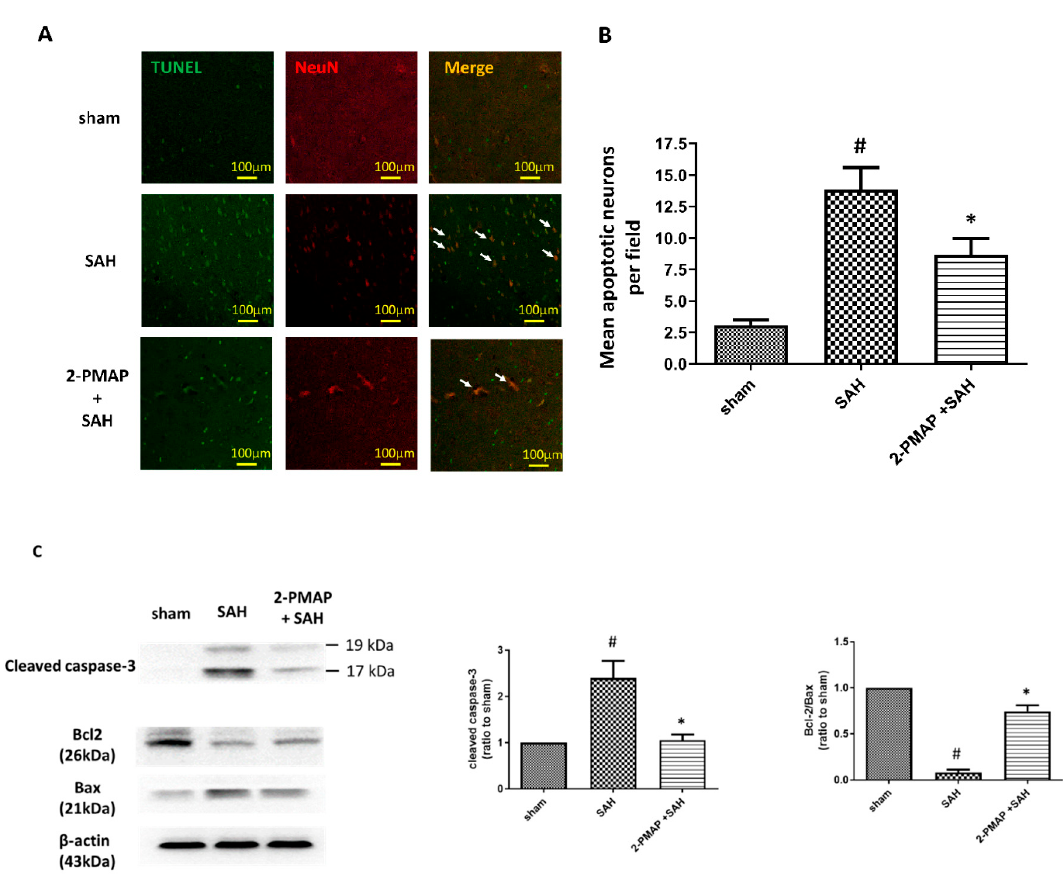
Figure 2. 2-PMAP decreased apoptotic neurons in SAH rats. ( A ) TUNEL staining was utilized to detect apoptotic neurons in SAH rats after 2-PMAP treatment. Scale bars: 100 µm. NeuN was used as a neuron marker. Representative immunofluorescence staining of neuronal nuclei (NeuN, red) and cell death (TUNEL, green). Images of each group are displayed as single staining results for NeuN and TUNEL, and a fused image displays both cells (green and red). SAH induced the development of apoptotic neurons in the brain tissues, whereas 2-PMAP decreased neuronal apoptosis (arrows). ( B ) Percentage of apoptotic neurons in the brain tissues 48 h after SAH. ( C ) Western blotting was utilized to measure the protein levels of cleaved caspase-3, Bcl-2 and Bax in brain tissues. Left panel: representative expression of cleaved caspase-3, Bcl-2 and Bax protein of brain tissues. Beta-actin was used as its internal control. Right panel: quantification of cleaved caspase-3 and relative ratio of Bcl-2 to Bax activity. Data are shown as mean ± SD ( n = 6 for each group); *, p < 0.05, significantly different from the SAH group. #, p < 0.05, significantly different from sham